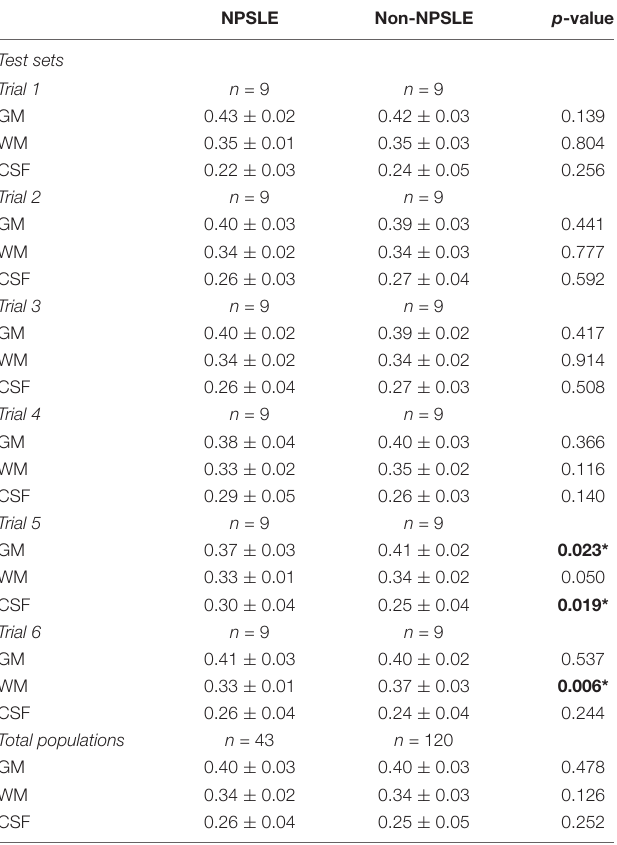
TABLE 3 | Comparisons of GM, WM, and CSF tissue fractions between NPSLE and non-NPSLE across test sets in all six trials and in the entire study population. NPSLE Non-NPSLE p